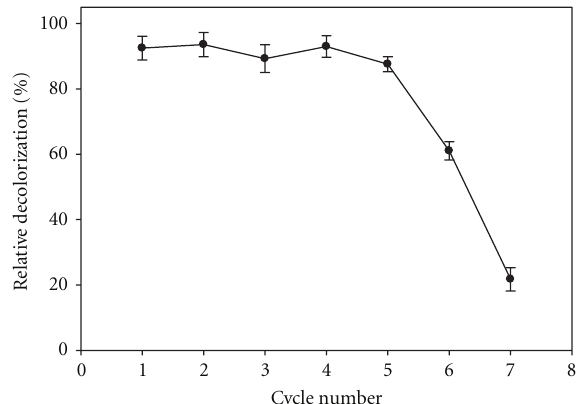
Figure 5: Reusability of immobilized laccase in the reaction condition. Data were mean values ±